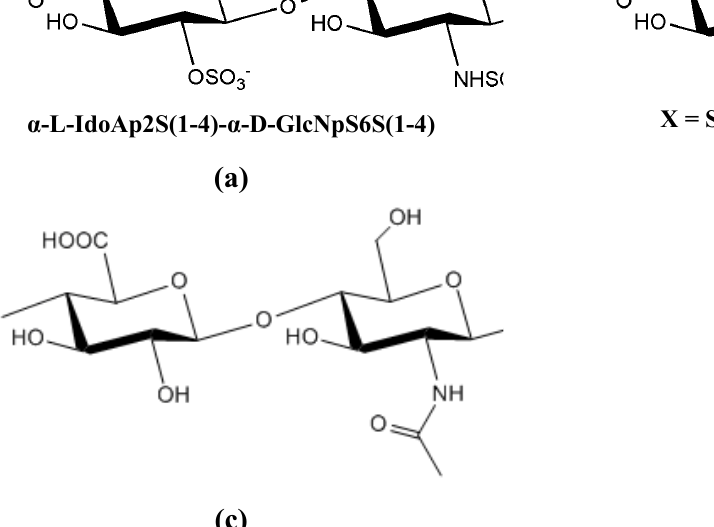
α -L-IdoAp2S(1-4)- α -D-GlcNpS6S(1-4) X = SO 3- or H, Y = SO 3- , CH 3 CO or H